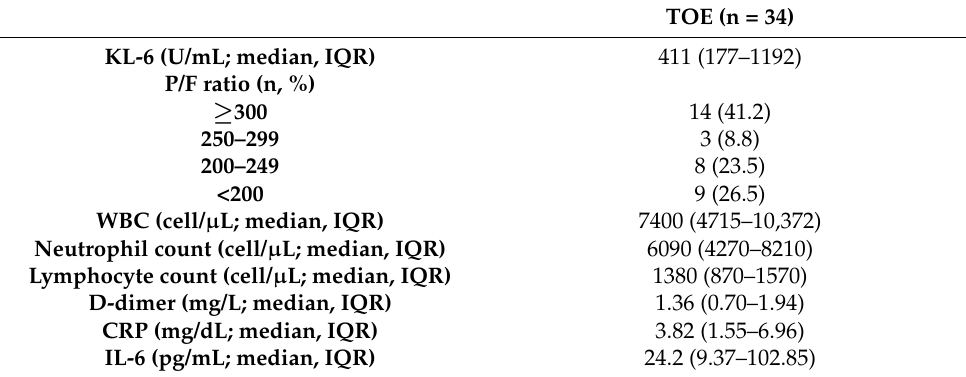
Table 1. Clinical and laboratory characteristics of the enrolled patients at the time of enrolment (n = 34).